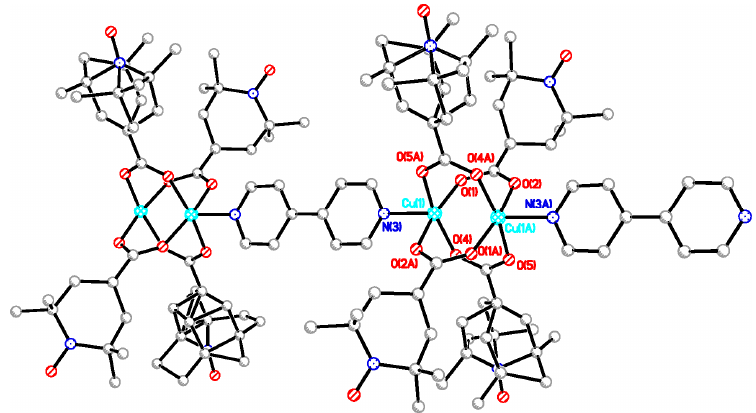
Figure 7. Packing diagram of [Cu 2 (caproxy) 4 (pds)] n ( 6 ). Hydrogen atoms are omitted for clarity. Dotted lines denote the hydrogen bondings.